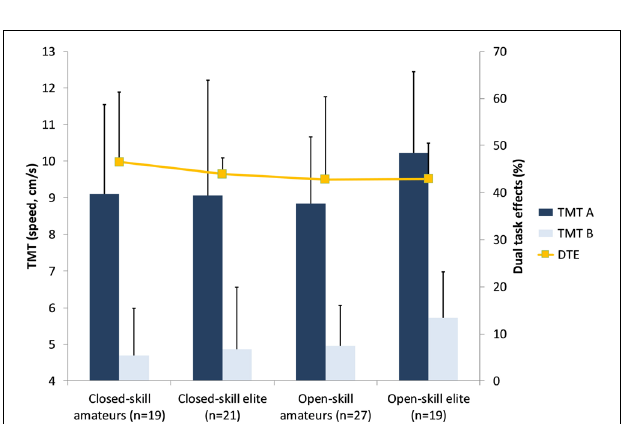
FIGURE 6 | Dual Task Effects for the Trail-Walking-Test as a function of expertise and type of sport ( ∗∗ p < 0.01).